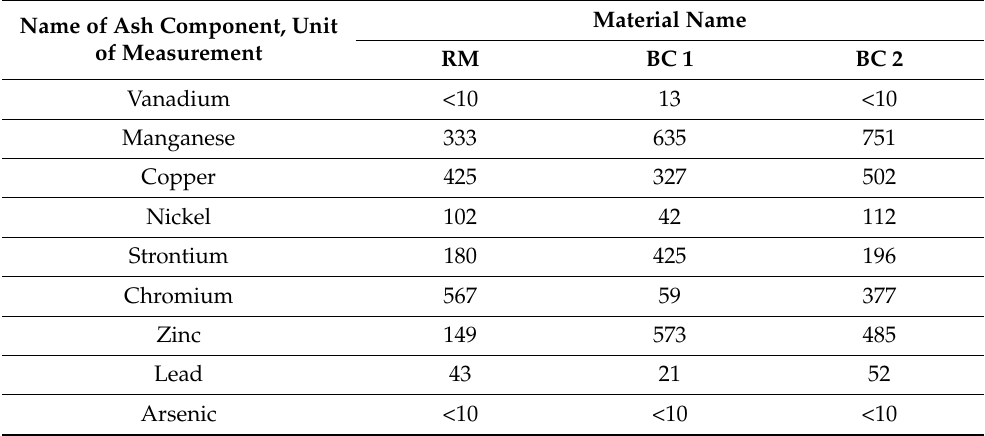
Table 6. Data on the content of trace elements in the ash of the original husk (RM) and biochar ash (BC 1 and BC